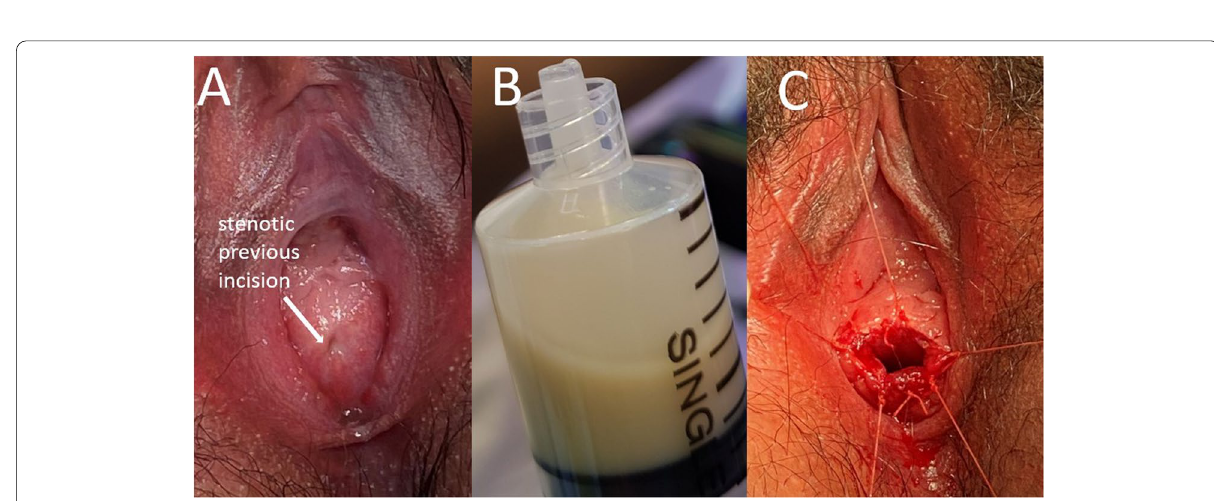
Fig. 3 Adolescent imperforate hymen (IH). A IH with the scar of stenotic previous incision seen with tiny opening that shows pus dripping. B Drained pus from vagina. C completed secondary